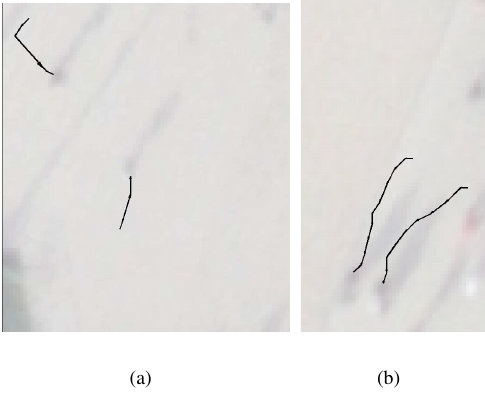
Figure 4: (a) Detected motion paths for two persons walking in opposite directions, (b) Detected motion paths for two persons which are walking very close to each